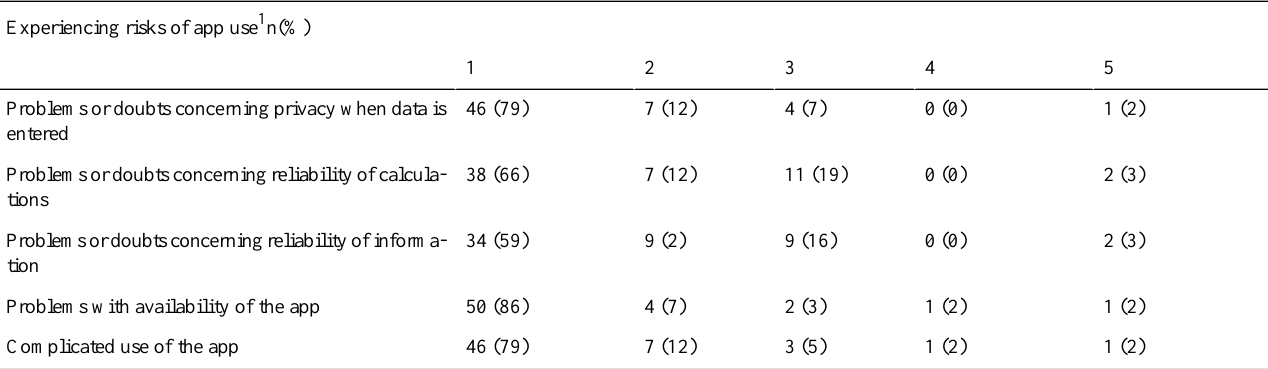
Table 6. Risks experienced by use of apps for regulation of blood glucose levels